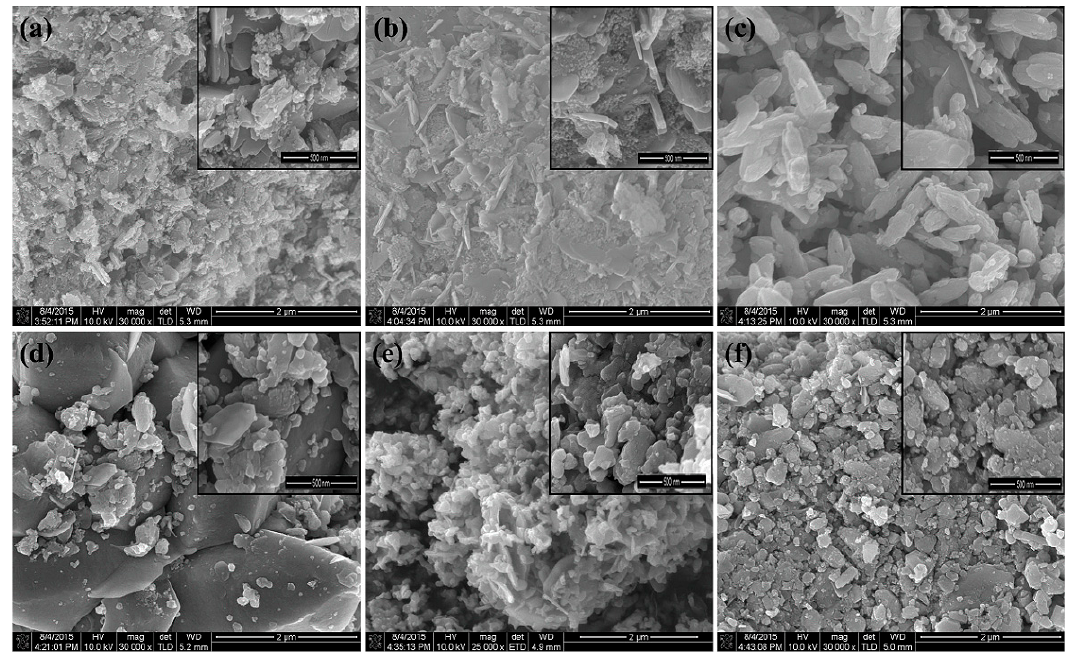
Figure 4. Surface morphology of V-doped ZnO. ( a ) Pure ZnO, ( b ) Zn 0.98 V 0.02 O, ( c ) Zn 0.96 V 0.04 O, ( d ) Zn 0.94 V 0.06 O, ( e ) Zn 0.92 V 0.08 O, and ( f ) Zn 0.90 V 0.10 O.